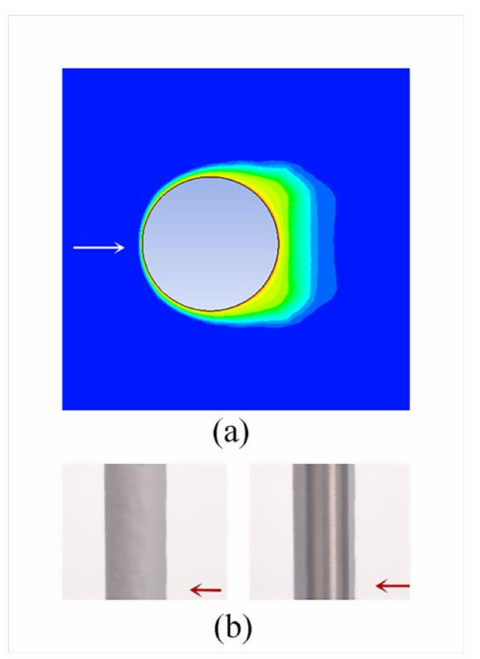
Figure 7. Comparison of frost morphology(( a ):Present model,( b ):Experimental